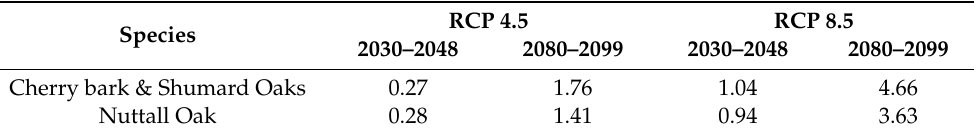
Table 2. Estimated average percentage changes in the annual radial growth rate of red oaks under climate change relative to the historical average climatic conditions